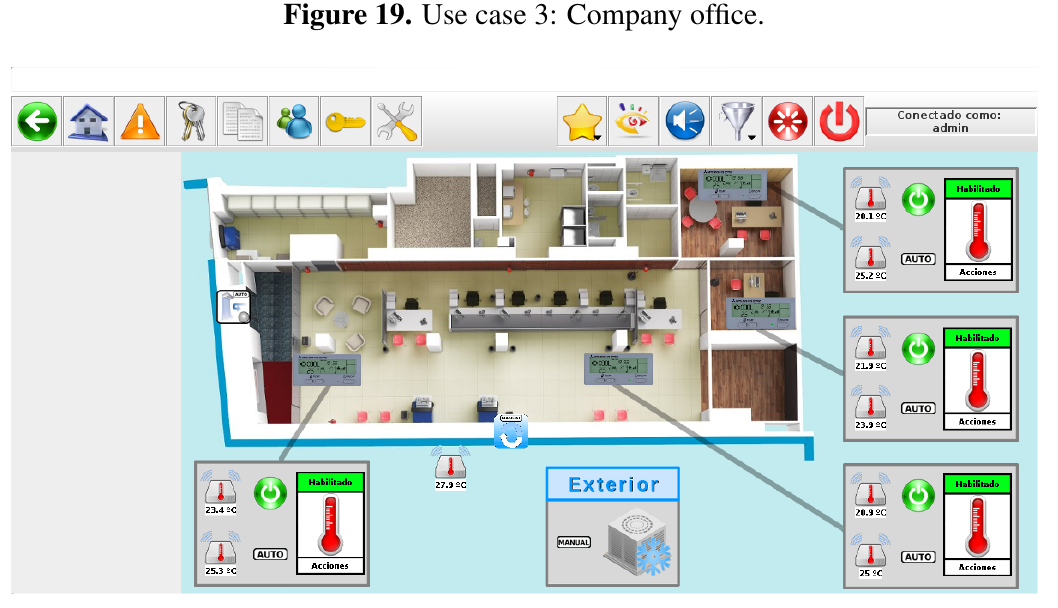
Figure 19. Use case 3: Company